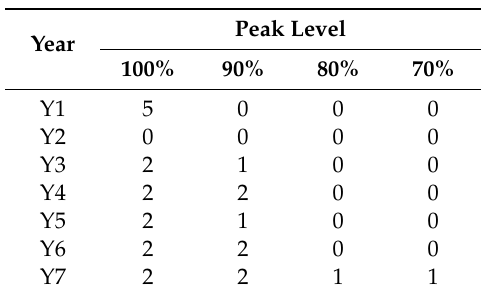
Table 9. Substation upgrades required for each studied scenario.